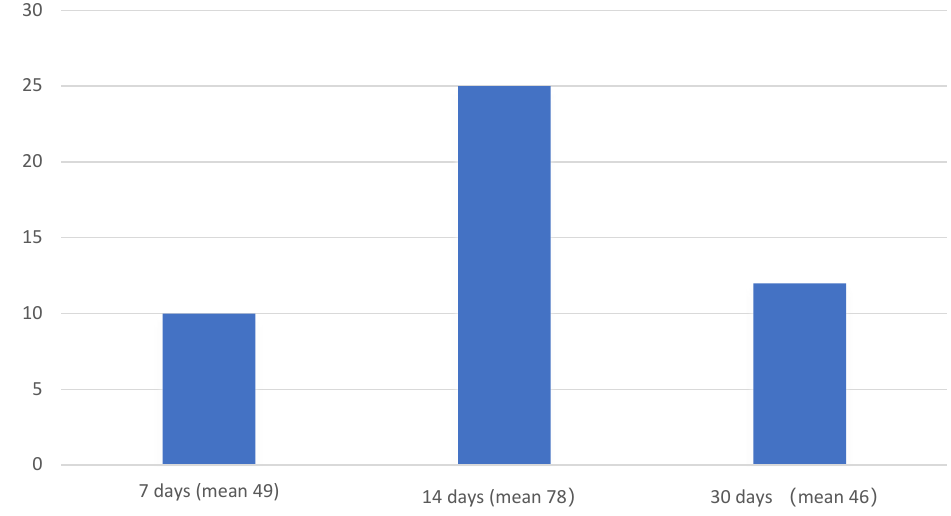
Figure 4. Graphic that shows the means of fibronectin expression (blue columns) at 7, 14 and 30 days. The Analysis of Variance (ANOVA) test showed a significant statistical difference among the means obtained at 7, 14 and 30 days of treatment ( p -value < 0.05).